Question: Give a one-sentence summary of this figure.
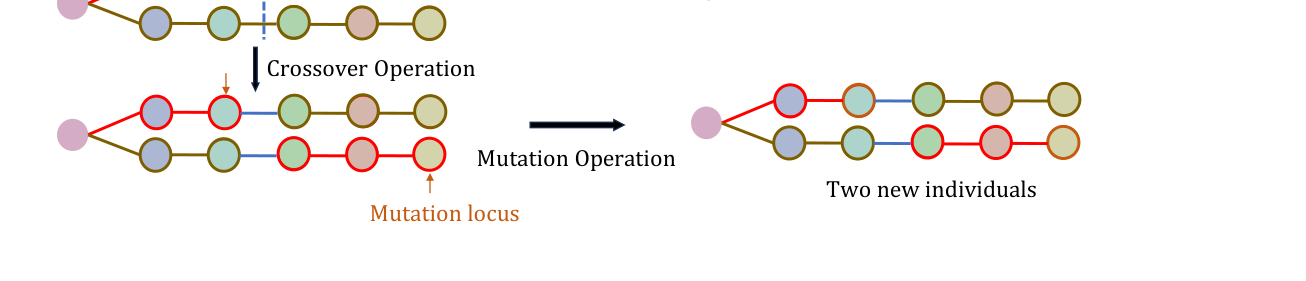
Answer: How to choose crossover and mutation loci. We provide an example to illustrate the crossover and mutation processes of GRGA in detail.